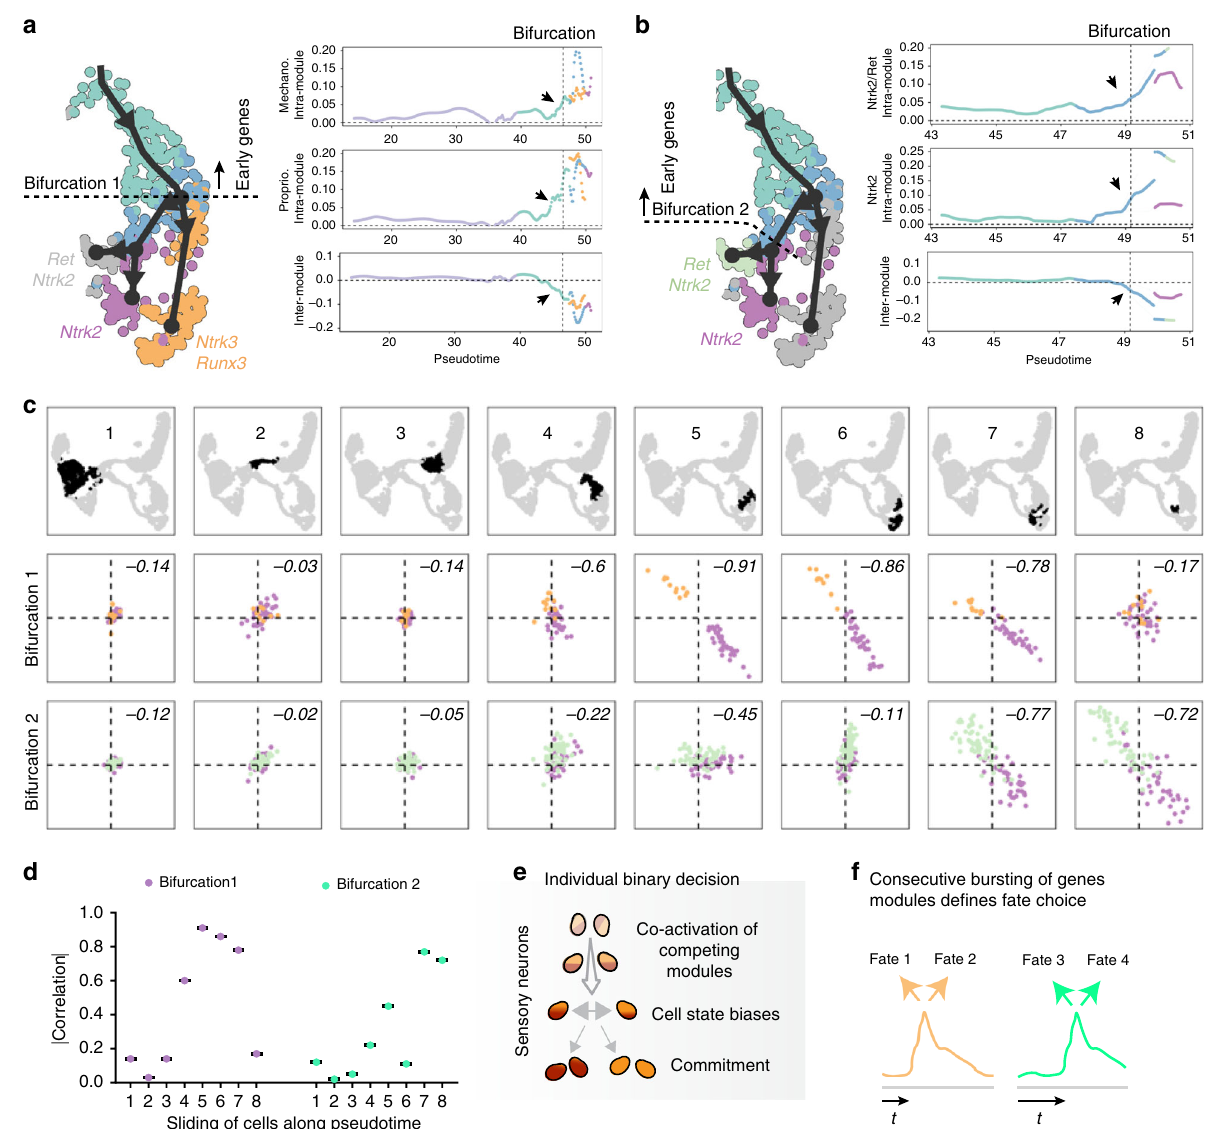
Fig. 4 Early fate-determining genes or modules show gradual intra-module coordination and inter-module repulsion during cell fate selection. a , b For bifurcations 1 and 2, plots in a pseudotime analysis show average local correlations of genes within and between branch-speci fi c modules, with gradual increase in coordination within each module and increasing antagonistic expression between the branch-speci fi c modules. c , d The plots show average local correlations of module genes with branch-speci fi c early gene modules for both bifurcations, in a set of cells with similar developmental time (marked by black dots). The difference between intra- and inter-module correlations, which characterize the extent of the antagonistic expression between the alternate modules, is shown in the upper right corner of the correlation plots, and represented in a graph in ( d ) as absolute value in Y axis which would re fl ect the repulsion between modules. e Schematic of binary fate decision in sensory neurons. f Repulsion of gene modules for the two bifurcations peaks at different pseudotime t